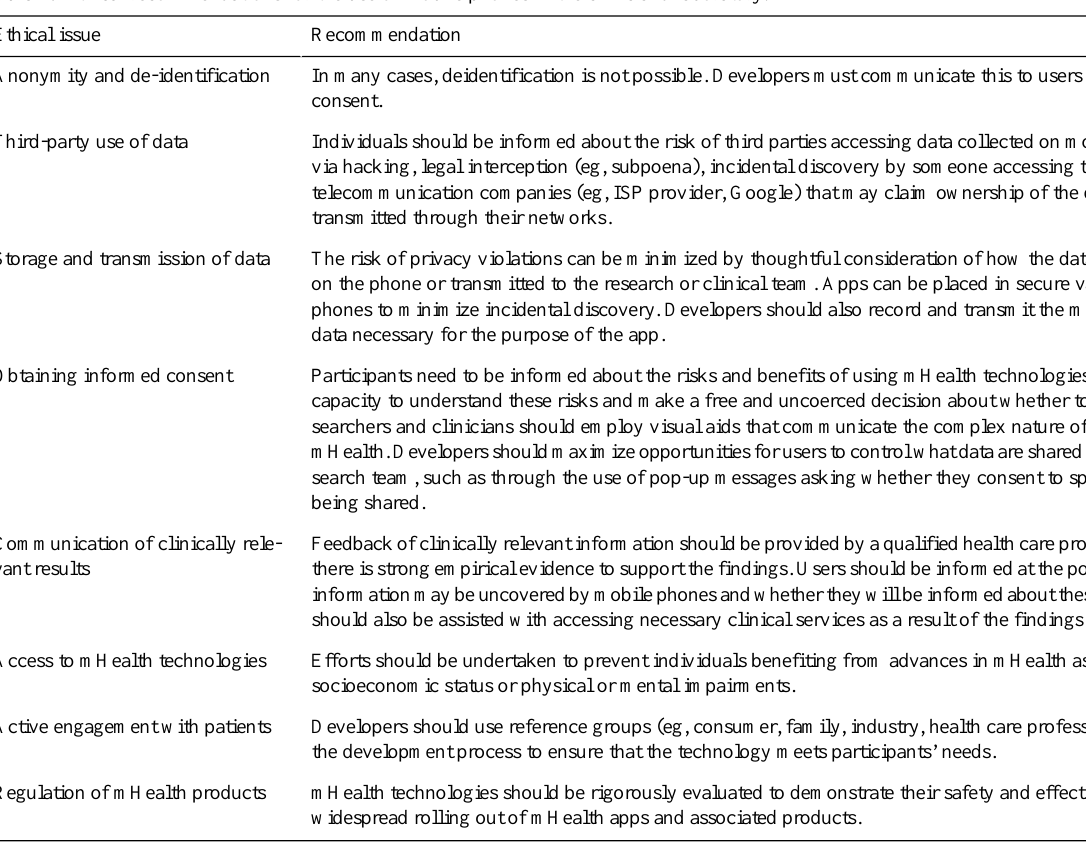
Table 1. Ethical recommendations for the use of mobile phones in the clinic and